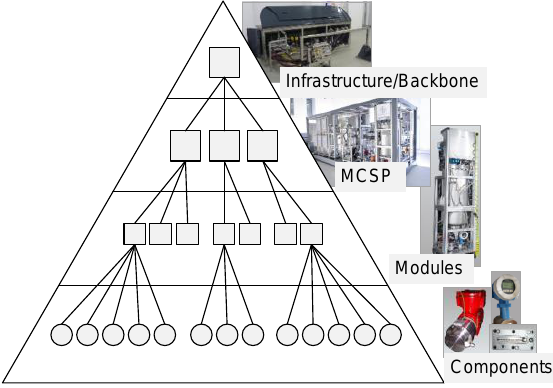
Figure 1. Hierarchical structure of the physical elements within modular and continuously operated small-scale plant (MCSP)